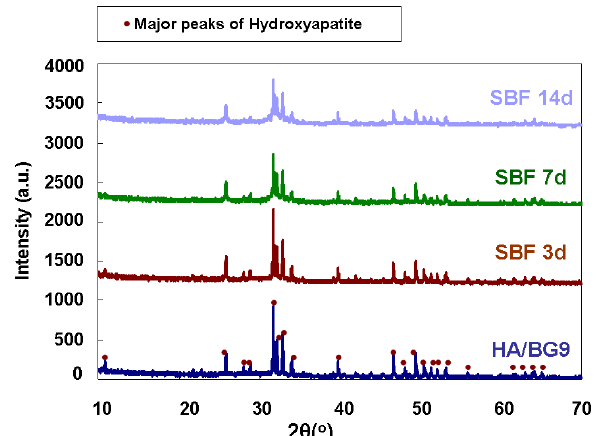
Figure 7. XRD spectra of the HA/BG_Ca composite treated at 750 °C for 3 hours before and after soaking in